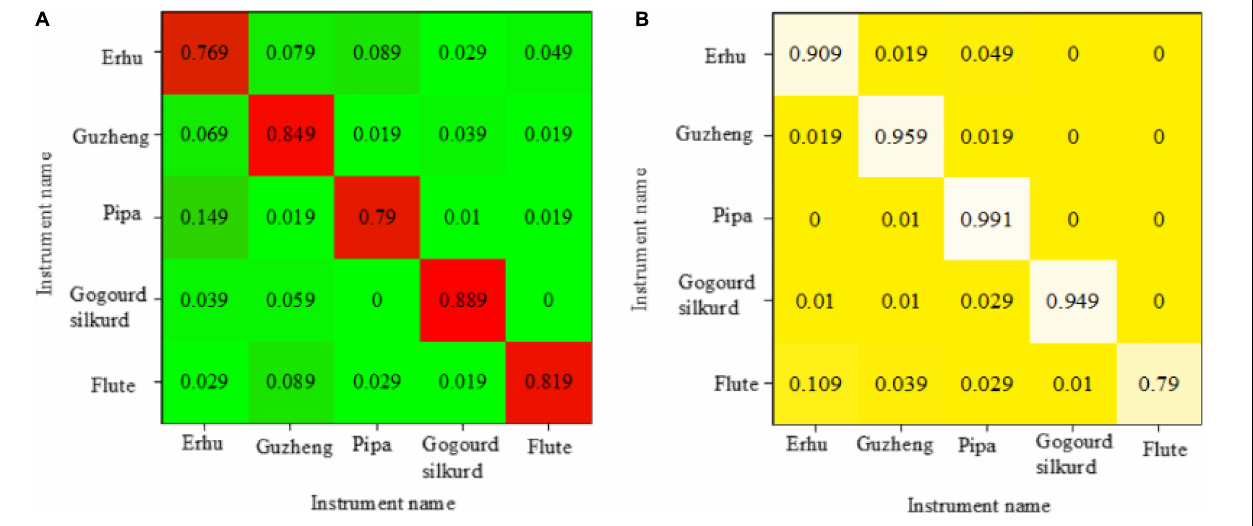
Frontiers in Psychology |